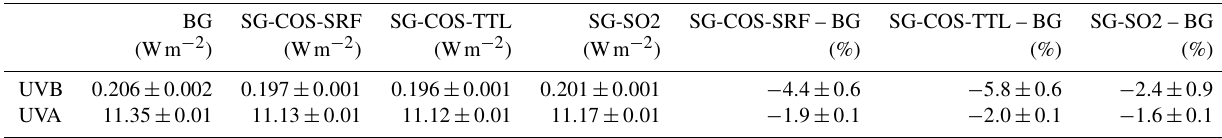
Figure 8. Zonal UVB and UVA surface changes per each season in percentage with respect to BG case in SG-COS-SRF ( a and b , respec- tively) and SG-SO2 (c, d) . All quantities are averaged over the years 2046–2055. Table 5. Summary of calculated globally and annually averaged quantities of UVB and UVA at surface. The last two columns show the calculated SG percentage changes with respect to the BG case (years